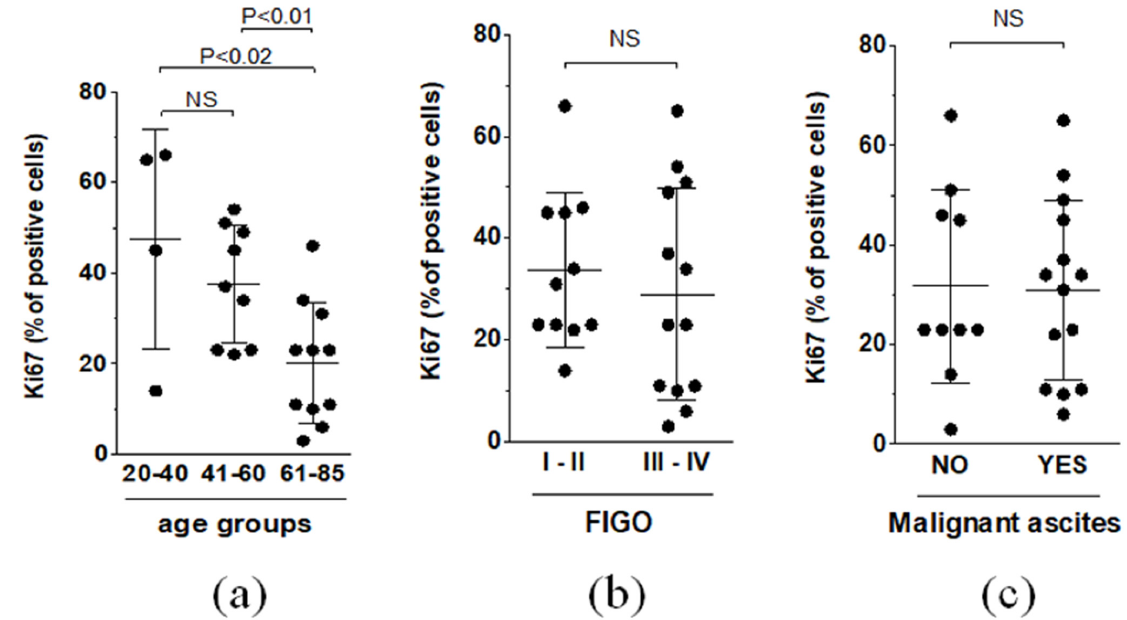
Figure 6. Comparison of the average areas representing the expression of Ki67 with respect to patient age ( a ), FIGO stage ( b ), and malignant ascites status ( c ). Experiments were performed on 24 separate ovarian tumors obtained from different patients. The results are expressed as the means ± SDs.